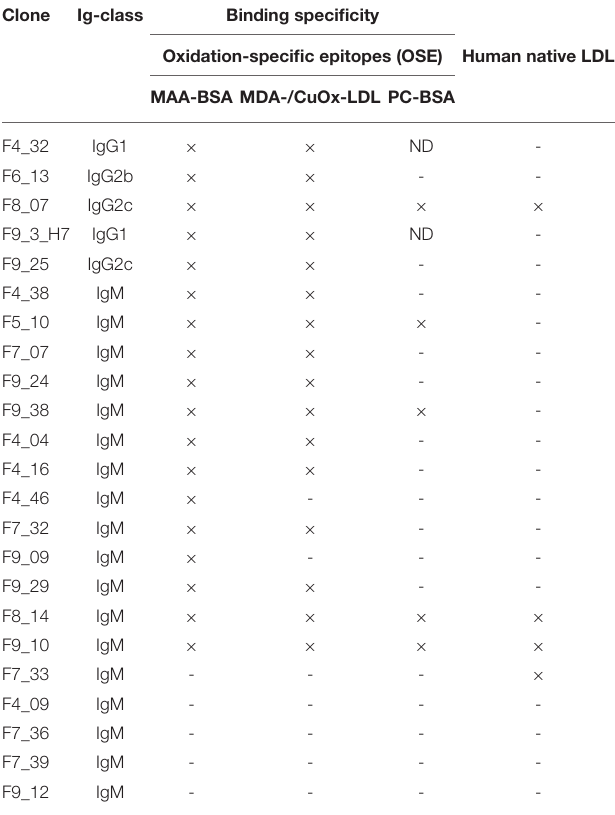
The hybridomas were generated from splenocytes of septic mice at day 10. Twenty IgG hybridoma-supernatants (diluted to 0.25 µ g/mL) and 18 IgM hybridoma-supernatants (diluted to 0.125 µ g/mL) were tested for binding to model oxidation-specific epitopes. Human native LDL served as control. Binding specificities of five positively-tested IgG, as well as all IgM clones, are shown. × , binding; -, no binding; MAA-BSA, malondialdehyde- acetaldehyde-modified bovine serum albumin (BSA); MDA/CuOx-LDL, malondialdehyde- modifed (MDA)/Cu 2 + -oxidized (CuOx)-LDL; PC-BSA, phosphorylcholine conjugated to BSA; ND, not determined.